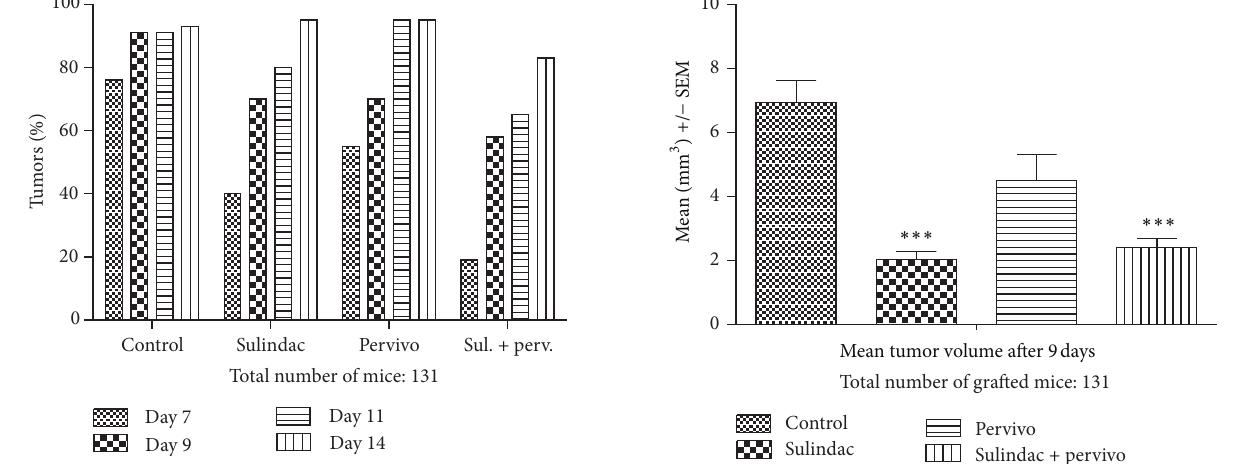
Figure 4: Mean tumor volume 9 days after Sarcoma L-1 cells grafting.